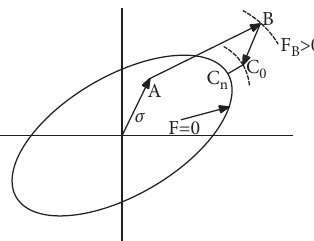
Figure 3: Diagram of the backward Euler integration